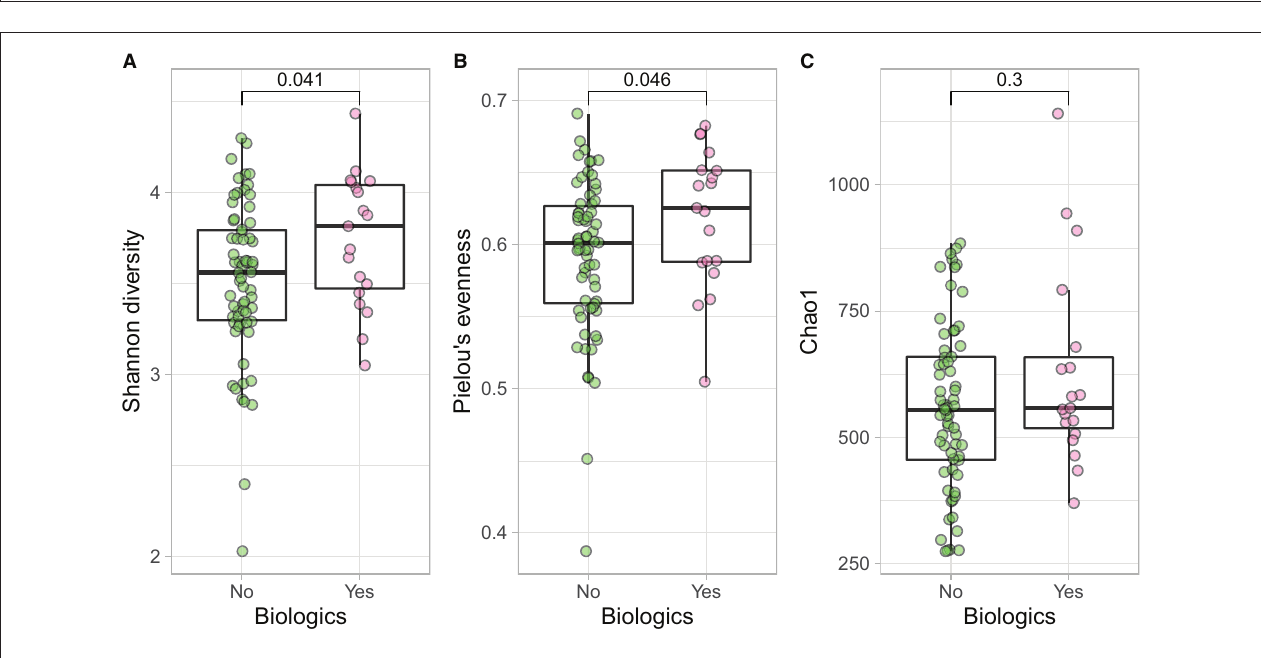
antibody therapy. Another example would be the inhibitory effect of thiopurines on growth of Mycobacterium avium subspecies paratuberculosis in vitro (84). Studies also shown